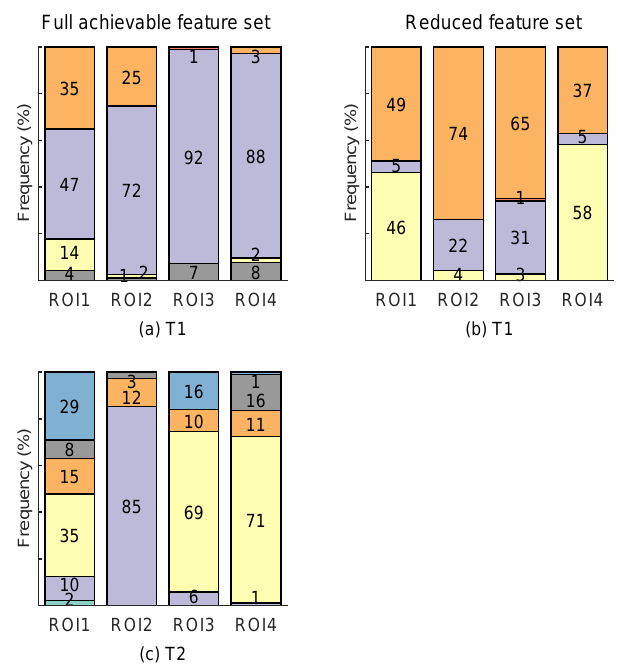
Figure 11. The segments assigned to the pixels in the four regions of interest by the segmentation of the two TerraSAR-X scenes (T1 and T2). To the left: segmentation of T1 and T2 with full achievable feature set. To the right: segmentation of T1 with reduced feature